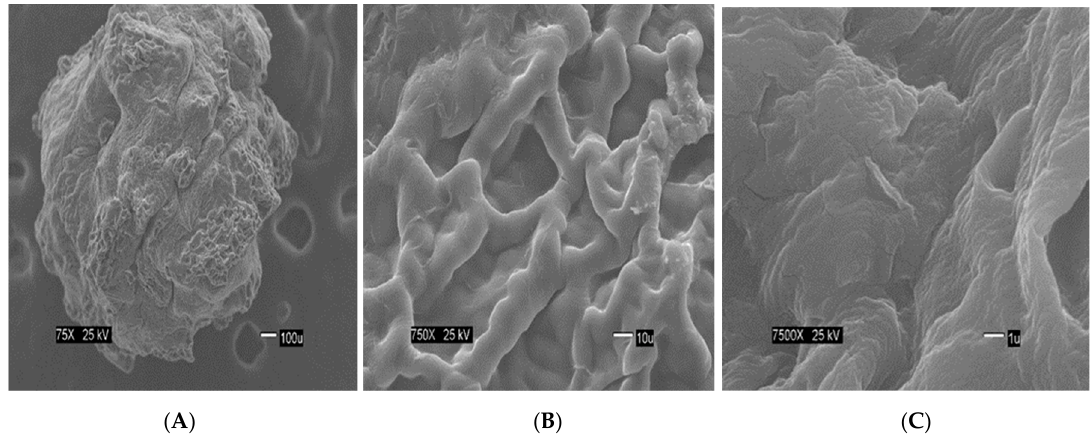
Figure 4. SEM images at three different magnitudes of CA-SCGs (3:3) beads: ( A ): 75×, ( B ): 750× and ( C ) : 7500×.